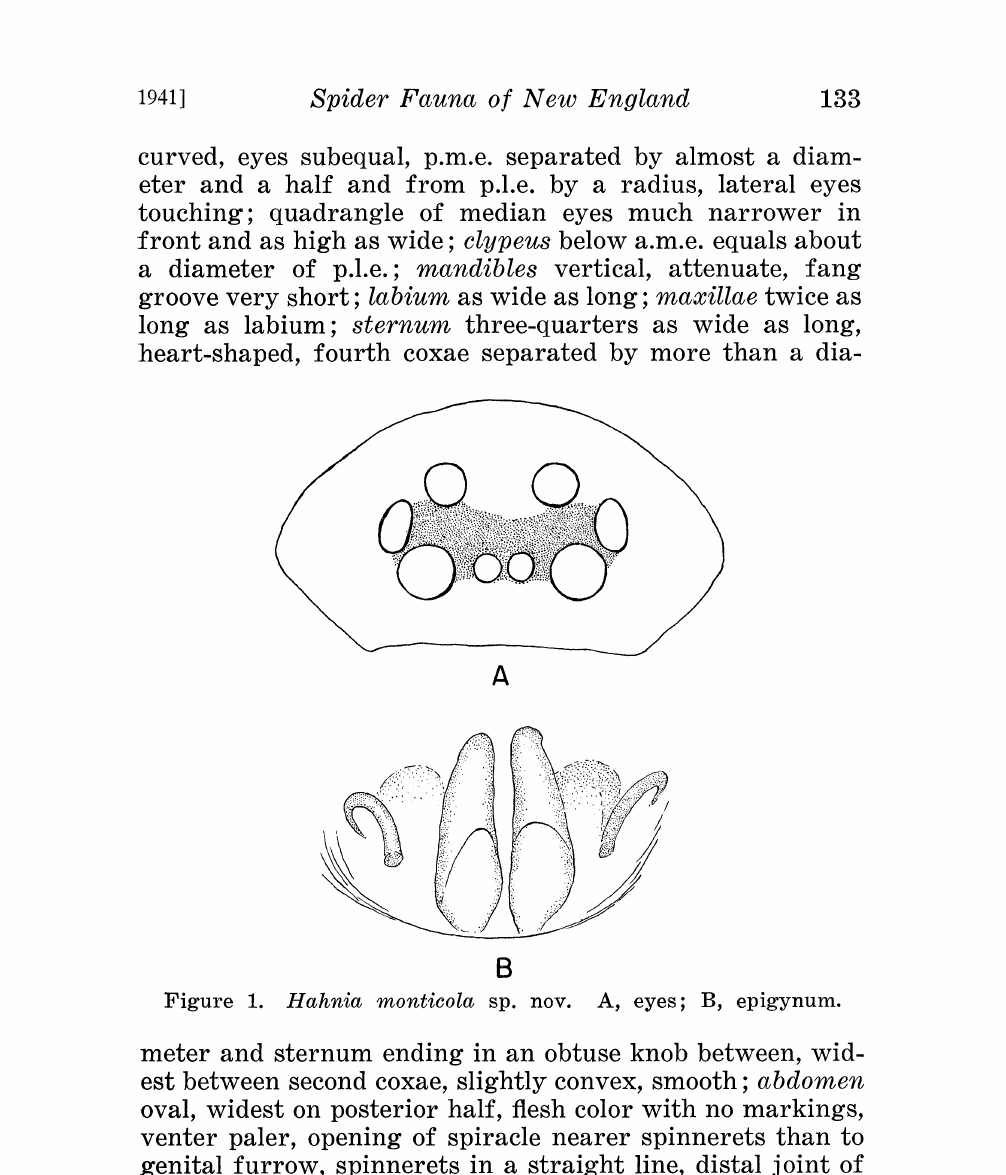
Figure 1. Hahnia monticola sp. nov.